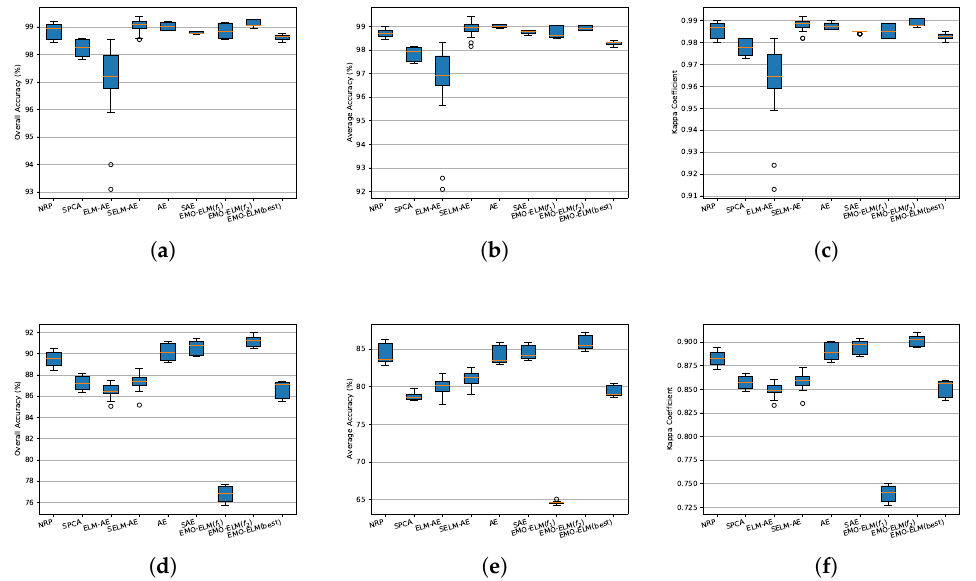
Figure 8. Box plot of SalinasA and KSC data sets. ( a – c ) denotes the box plot of the SalinasA data set in terms of OA, AA, and Kappa, respectively; ( d – f ) represents the box plot of the KSC data set with respect to OA, AA, and Kappa, respectively. The edges of boxes are the 25th and 75th percentiles and the middle lines indicate the median line. Whiskers extend to the maximum and minimum